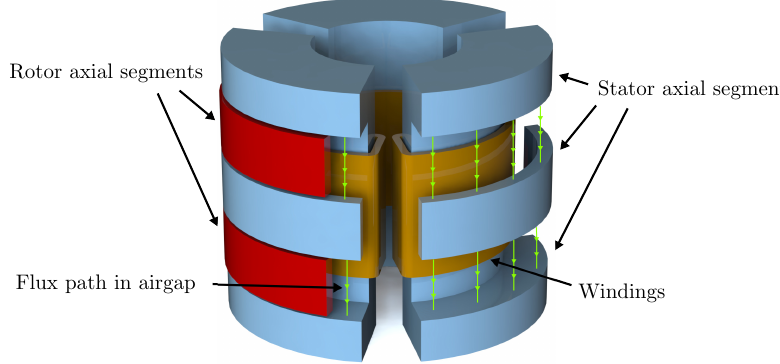
Figure 2. Schematic view of the proposed axial flux machine. The stator is drawn in blue, with orange windings, and the rotor is drawn in red. Only electromagnetically-active material is included in the picture. The concept drawing has three stator poles with separate winding phases and one 180 ◦ rotor pole. The rotor is split into two axial segments. The magnetic flux lines in the air gap are drawn in